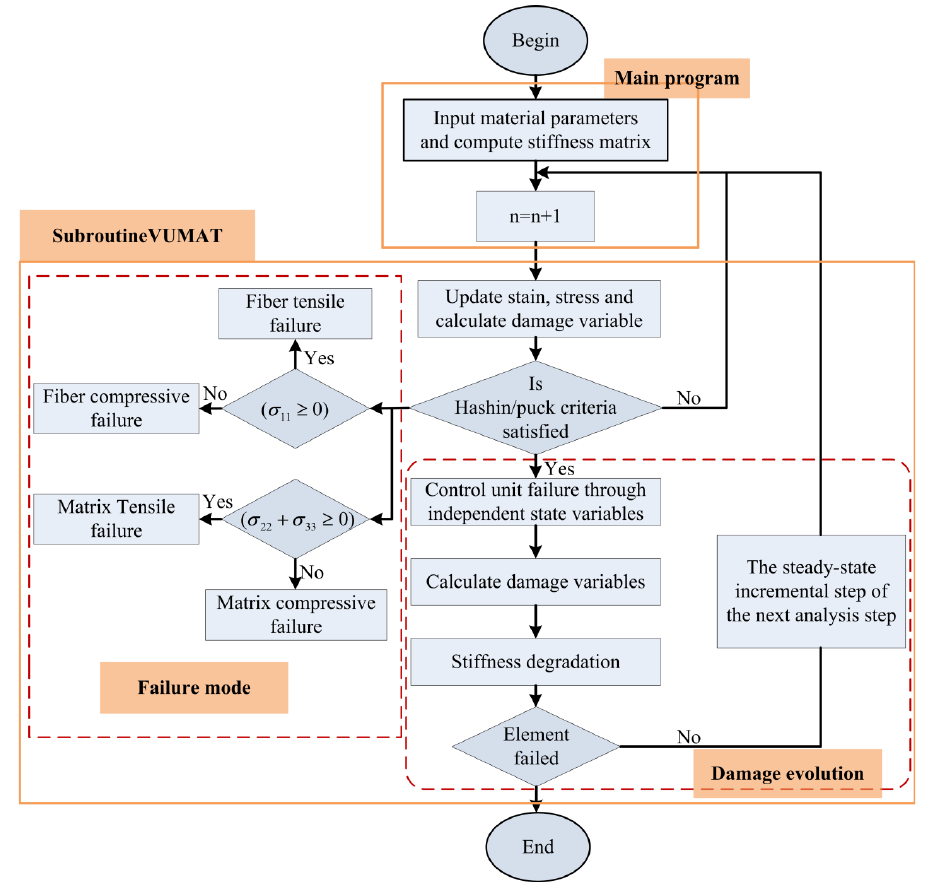
Figure 4. Flowchart for the numerical process of the VUMAT subroutine under ABAQUS.